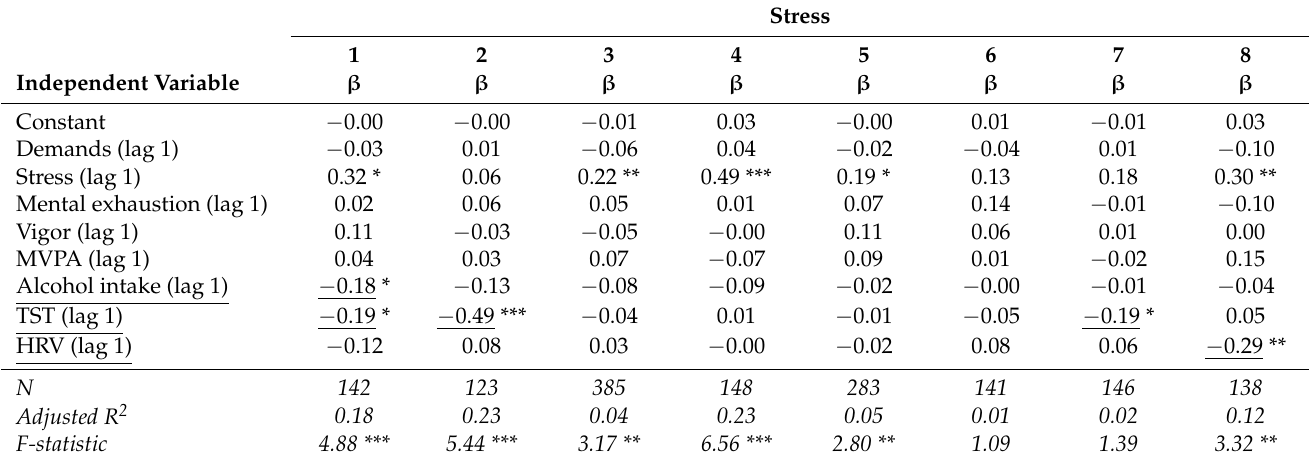
Table 5. Vector autoregression models for stress per participant (1–8).